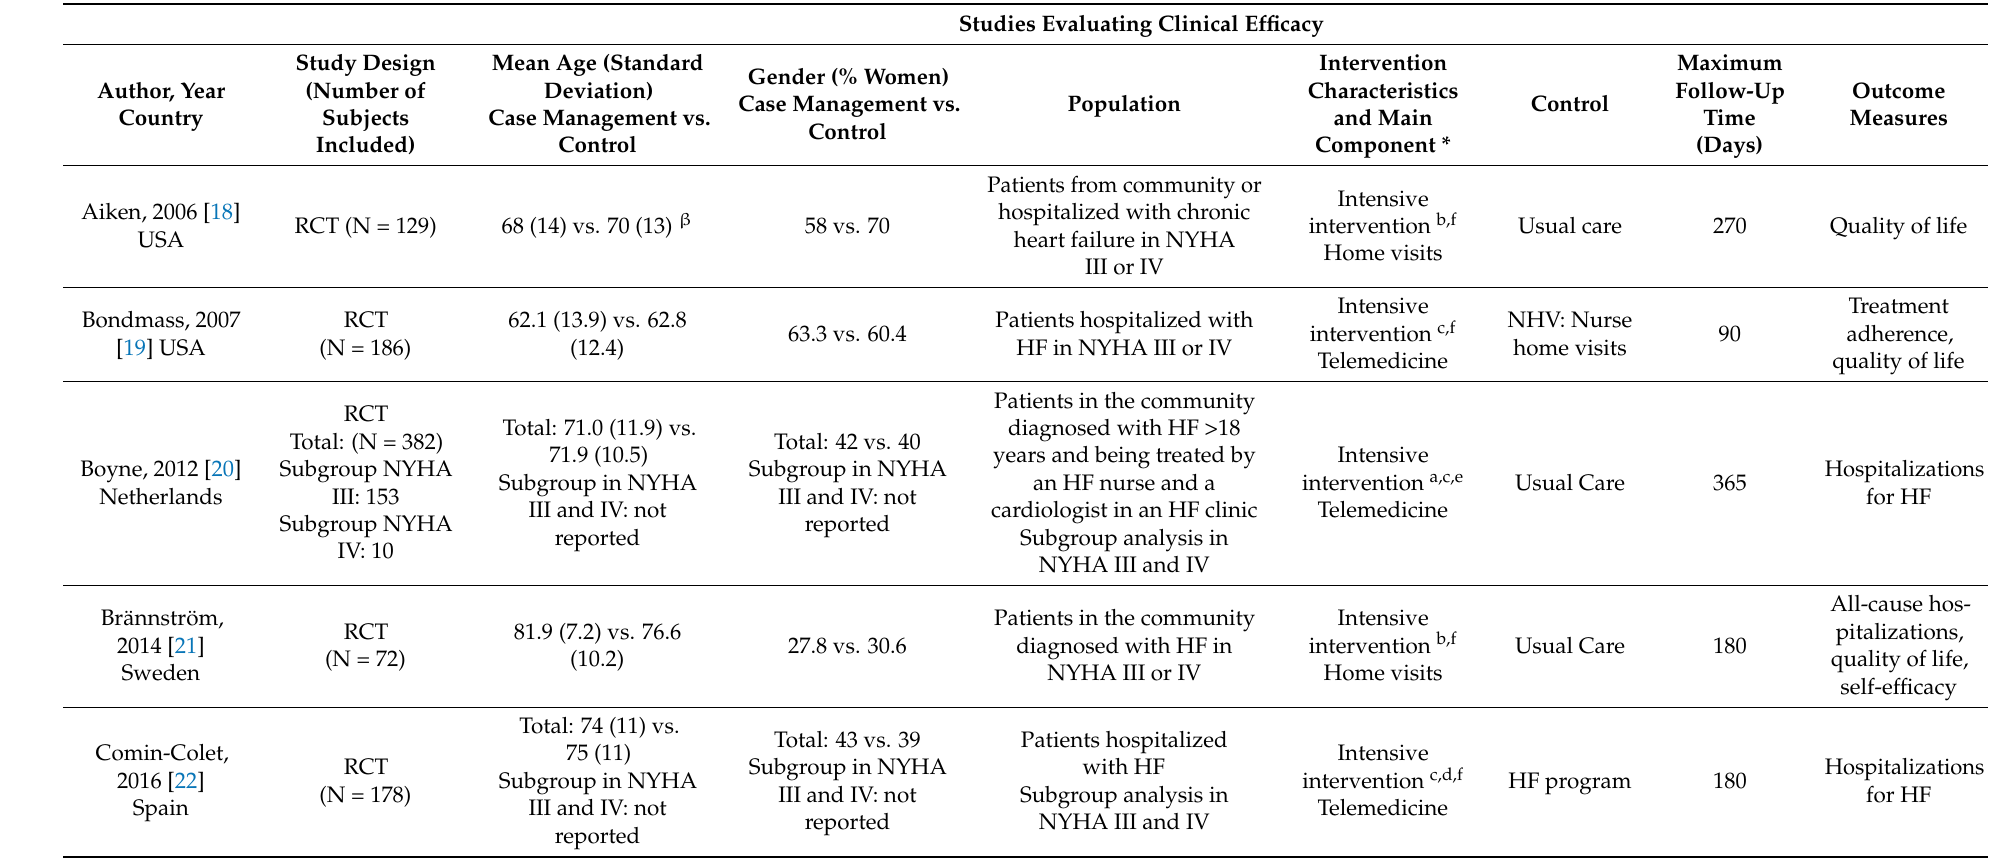
Table 1. Characteristics and summary of results of the included studies for the evaluation of case management in advanced heart failure